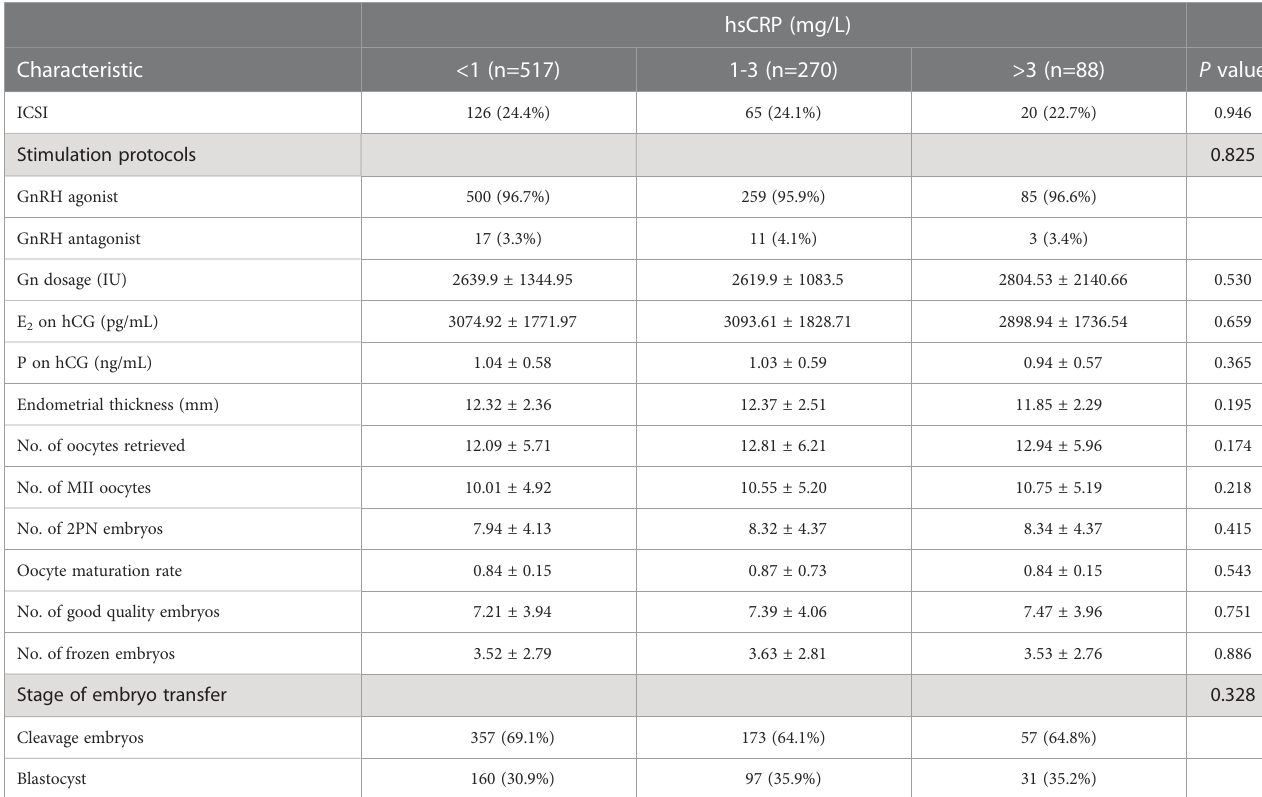
TABLE 2 Basic cycle characteristics of women with low, moderate and high hsCRP.